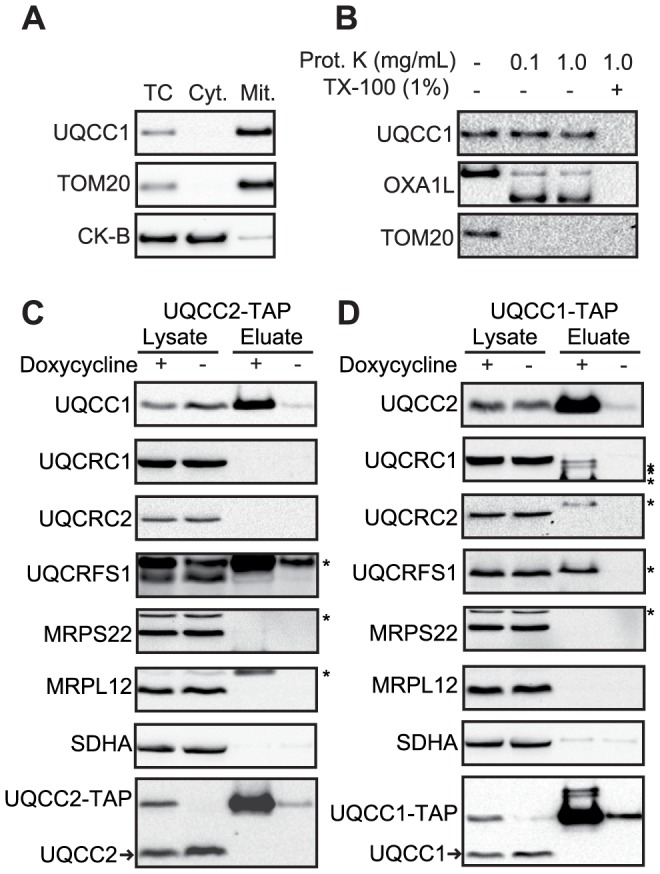
UQCC2 interacts with mitochondrial protein UQCC1.(A) SDS-PAGE analysis of HEK293 cellular fractions shows that UQCC1 is enriched in the mitochondrial fraction, similar to the mitochondrial protein TOM20. A cytosolic marker creatine kinase B-type (CK-B) was used. TC: Total Cell, Cyt: Cytoplasmic fraction, Mit: Mitochondrial fraction. (B) Proteinase K protection assay performed using mitochondria with digitonin-permeabilized outer membranes shows localization of UQCC1 within the mitochondrial inner membrane. UQCC1, unlike outer membrane localized TOM20 and the inter-membrane localized part of OXA1L, is protected from proteolysis and degraded only after the inner membrane is dissolved with Triton X-100. Western blot analysis of single step affinity purified (C) UQCC2- and (D) UQCC1-TAP from doxycycline-induced HEK293 cells shows that UQCC1 co-purifies with UQCC2-TAP and UQCC2 co-purifies with UQCC1-TAP. Additional probing of the membranes for the complex III structural subunits UQCRC1, UQCRC2, UQCRFS1 and mitochondrial ribosomal subunits MRPS22 and MRPL12 did not reveal co-elution of these proteins. Asterisks with these subunits, including the one with UQCRFS1, correspond to bands at different heights that result from previous incubations. Complex II subunit SDHA was used to rule out non-specific protein binding. Non-induced cells were used as control. Antibodies used are indicated at the left. Arrowheads indicate endogenous UQCC1 and UQCC2.